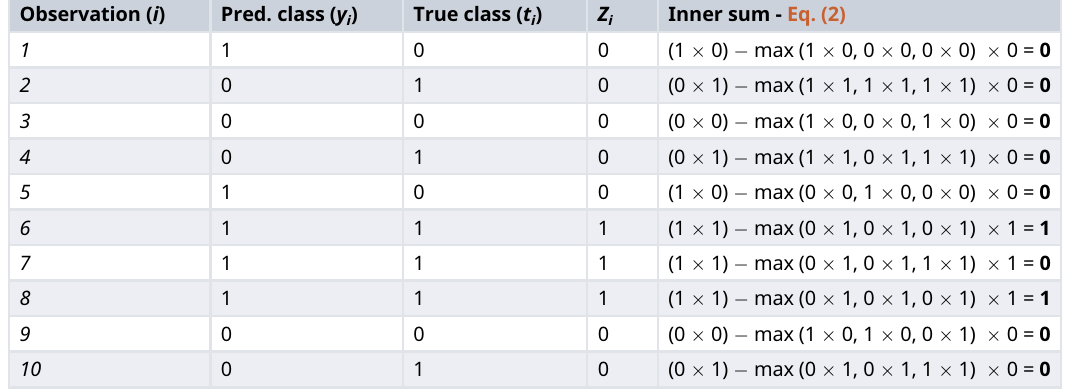
Table 3. Sample ShineThrough calculations for C 1. Z i , constant defined for observation i . Observation ( i